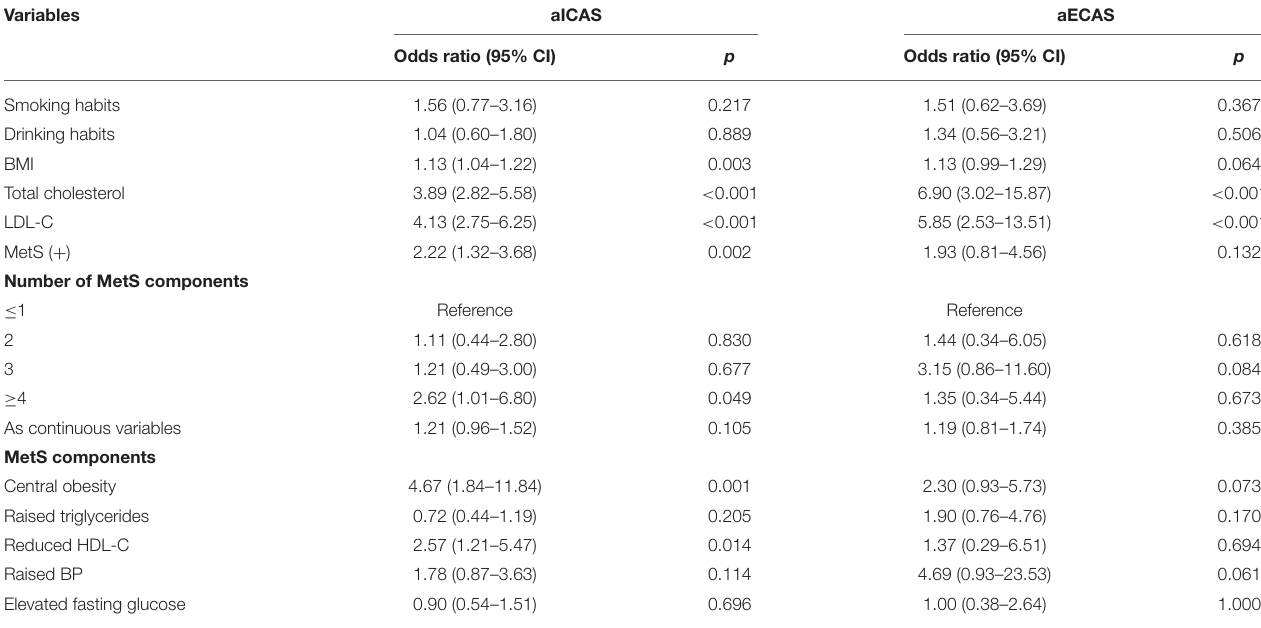
TABLE 3 | Univariate logistic regression analysis of the association of MetS with aICAS or aECAS. Variables